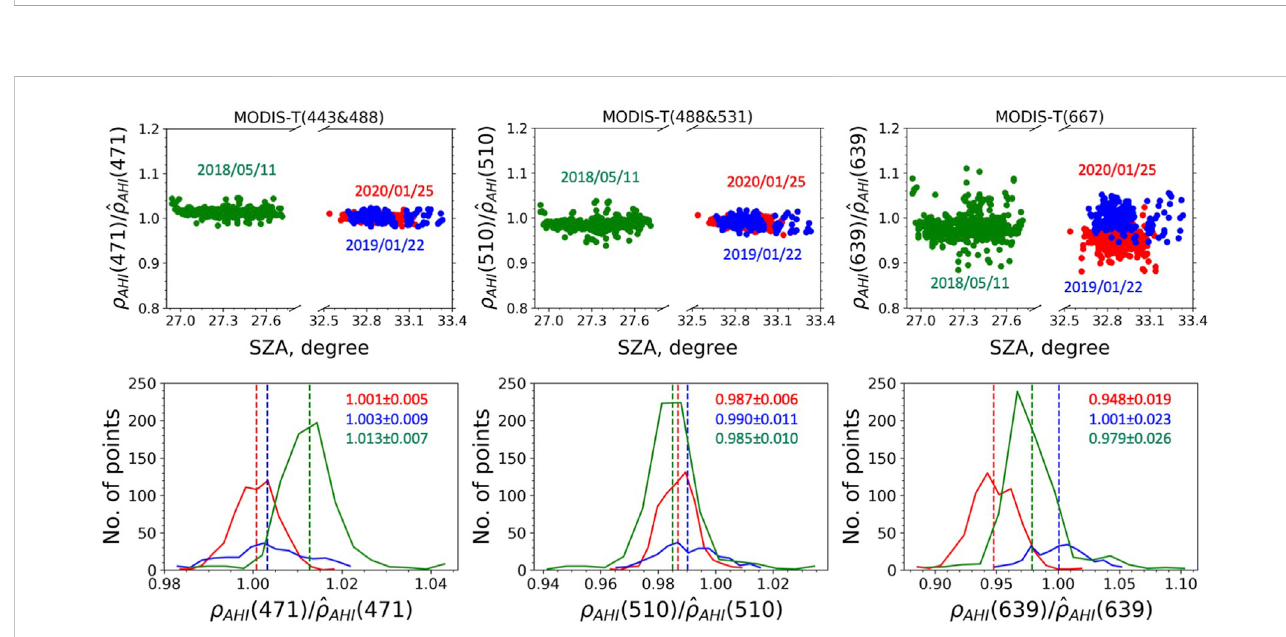
FIGURE 7 SameasFigure5,butfortheequivalentAHIre fl ectance ^ ρ AHI at471,510,and569 nmgeneratedusingMODIS-T443&488 nm,488&531 nm,and667 nm.